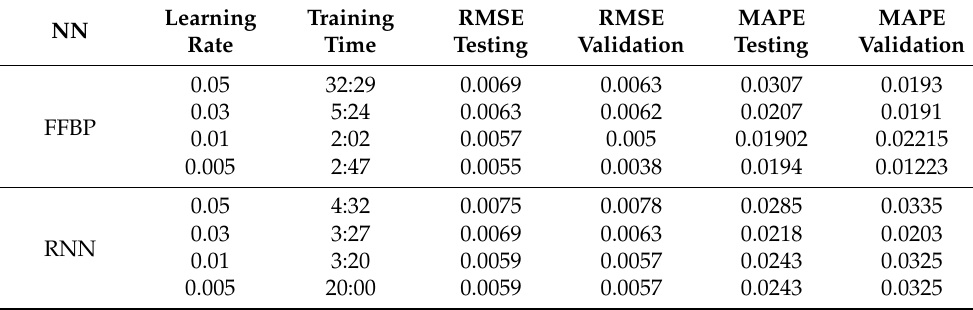
Table 6. Training and testing results of FFBPNN and RNN for case